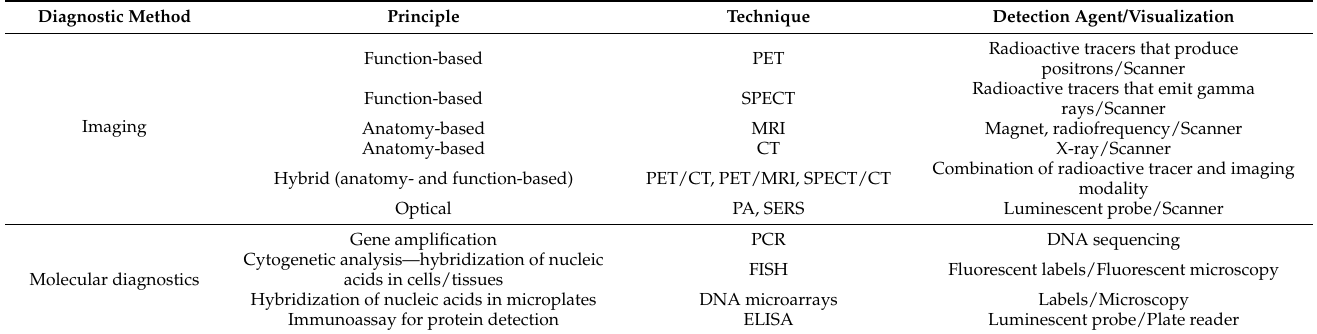
Table 1. Techniques used for cancer